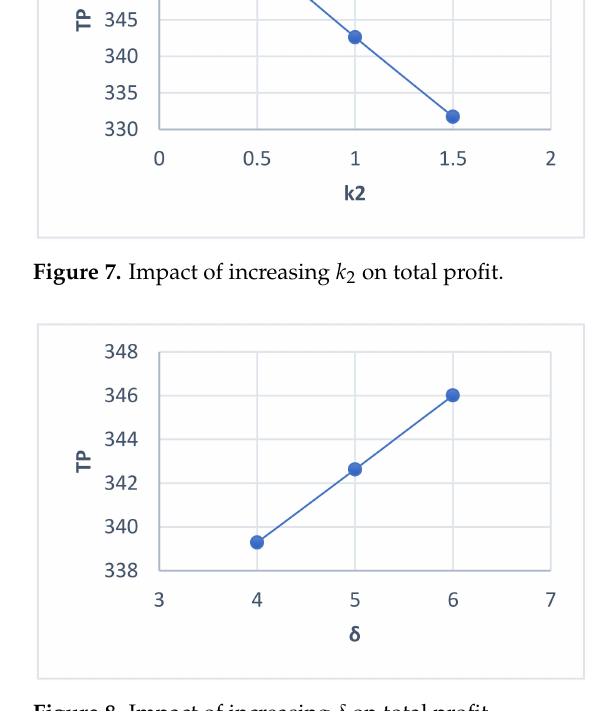
Figure 8. Impact of increasing δ on total